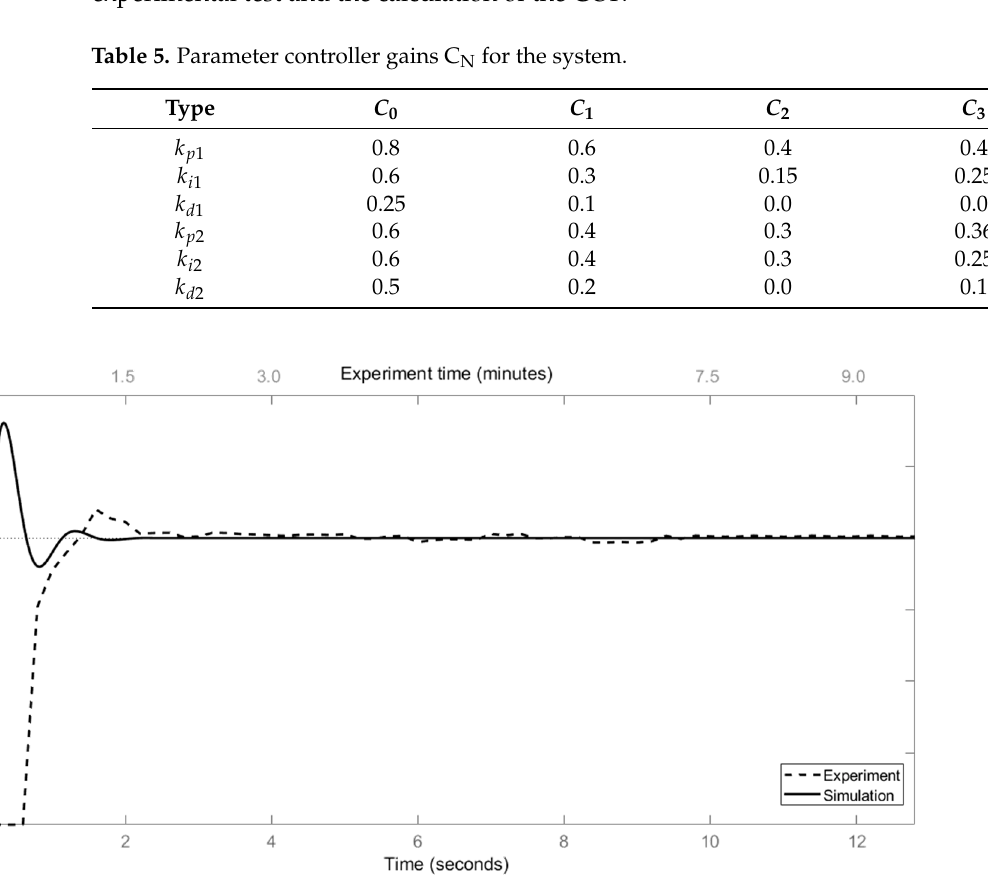
Figure 9. Response of the weak solution valve with PID 1 Figure 9 . Response of the weak solution valve with PID 1 .